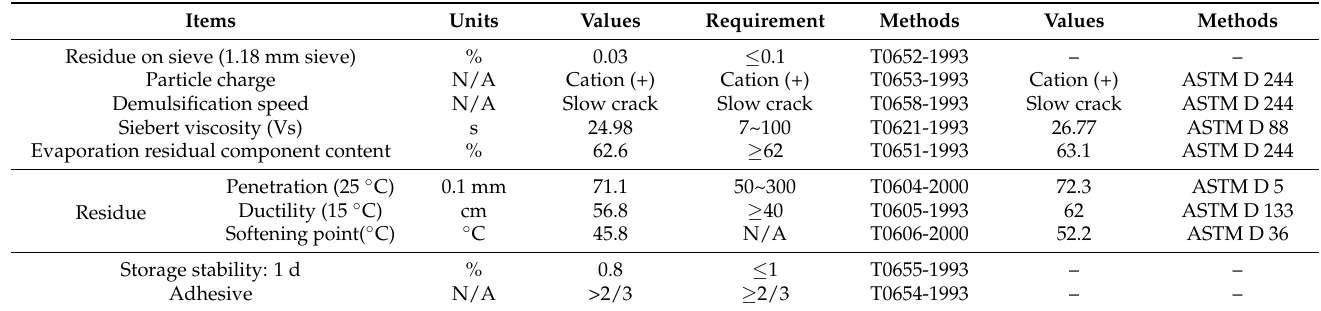
Table 1. Test results of emulsified asphalt properties.